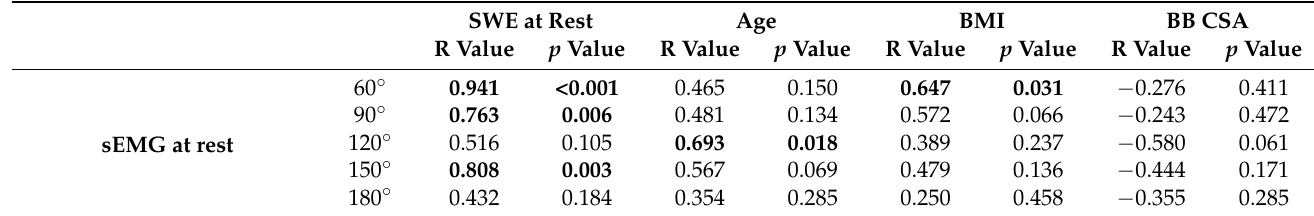
Table 5. Pearson correlation test findings for the surface electromyography measured at rest.